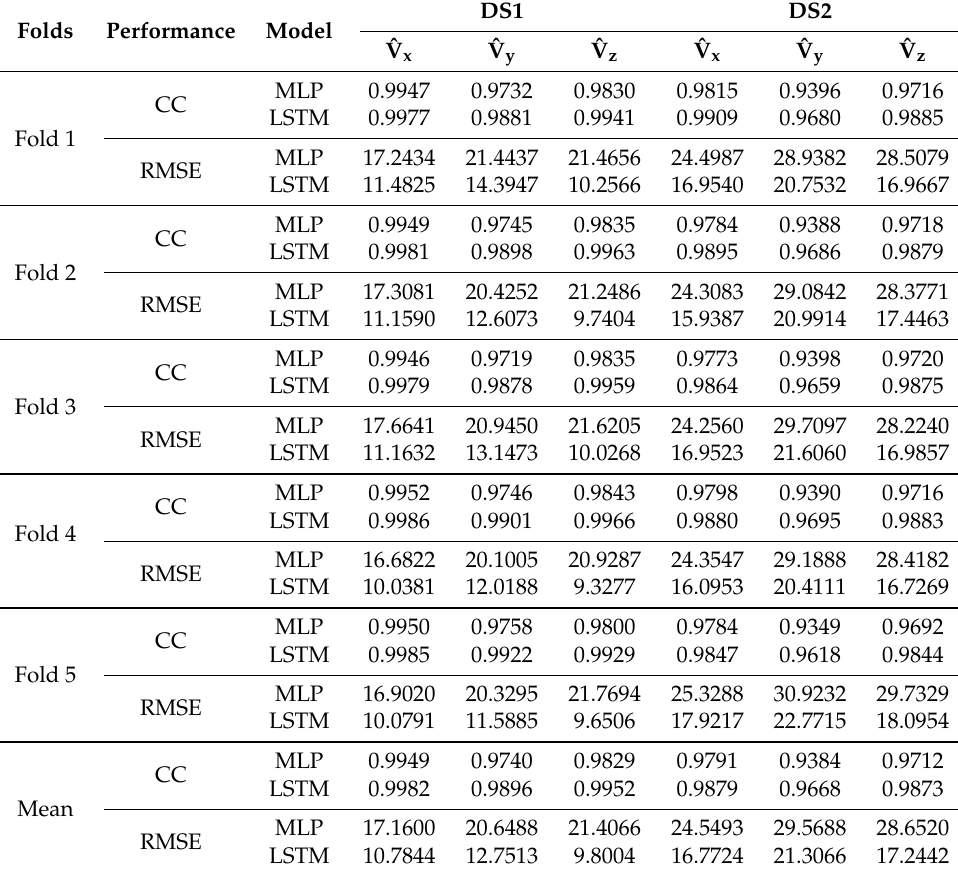
Table 3. Five-fold cross validation and average CC and RMSE between measured and derived Frank leads for the MLP and LSTM